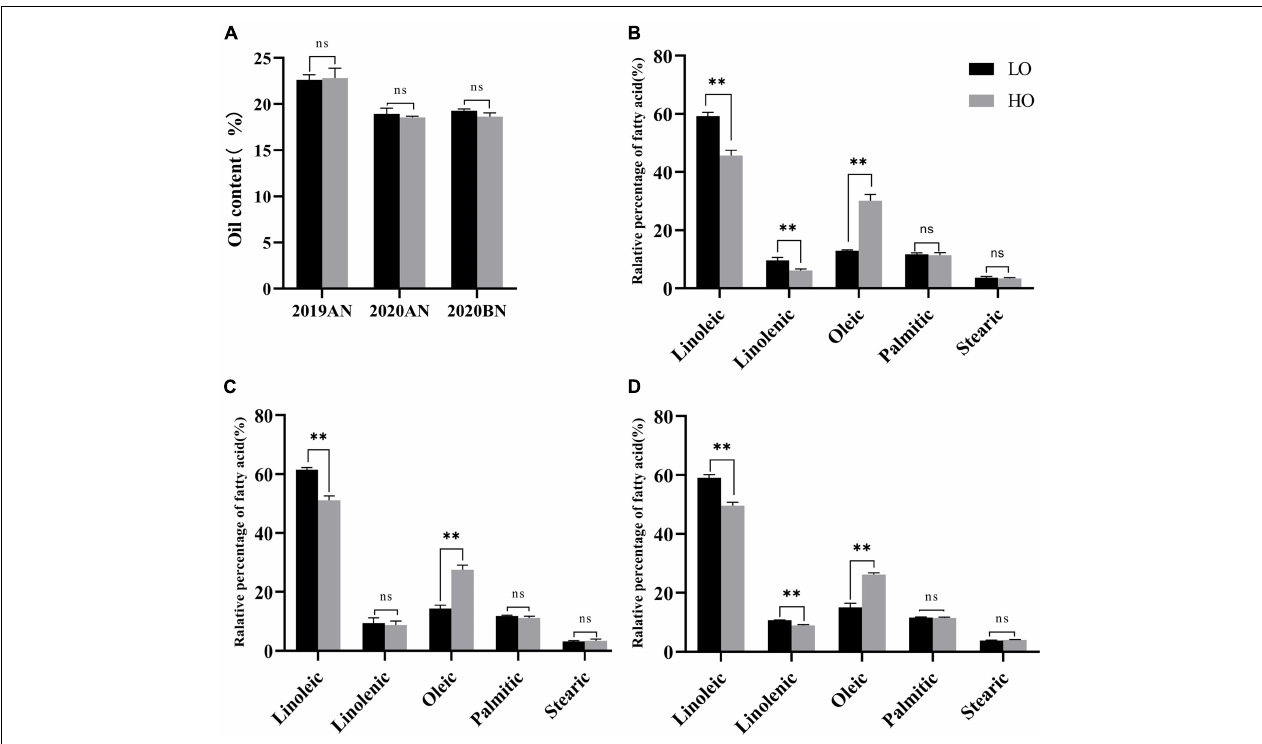
FIGURE 1 | Comparison of fatty acid content and fatty acid profiles between HO and LO. T -test was performed between the paired samples under different environments. ∗∗ and ns represent significant at P ≤ 0.01 and none significant, respectively. (A) Comparison of total fatty acid contents in 2019AN, 2020AN and 2020BN; (B) Comparison of fatty acid profiles in 2019AN; (C) Comparison of fatty acid profiles in 2020AN (D) Comparison of fatty acid profiles in 2020BN. 2019AN, 2020AN, and 2020BN represent the environment of Anning (2019, 2020), and Xishuangbanna (2020),